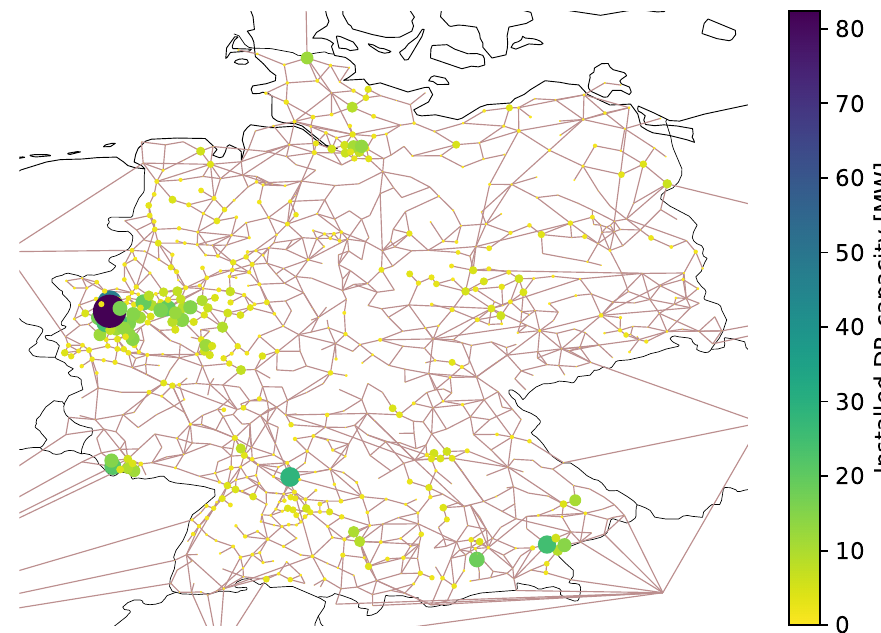
Figure 9. Spatial distribution of the installed DR capacity per grid